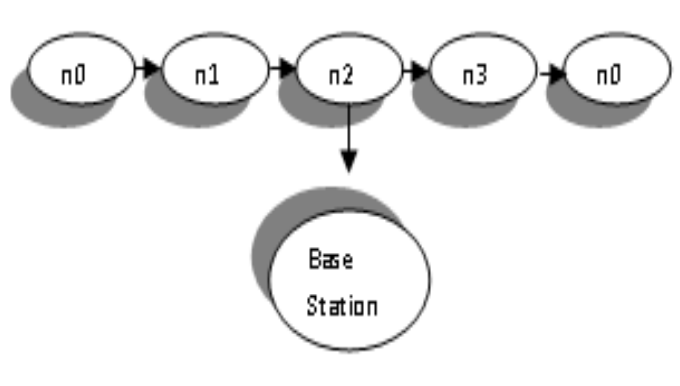
Figure 4. Chaining in PEGASIS.